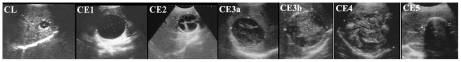
Ultrasound classification of cystic echinococcosis based on WHO expert consensus.CL: as a potentially parasitic cyst, indicates a very early stage of parasite development. CE1 or CE2: suggests active parasite. CE3a: is characterized by detachment cyst membrane and/or partial degeneration of cyst content, without daughter cysts, indicates a transitional stage. CE3b: suggests a transitional stage of parasite, partial degeneration of daughter cysts. CE4 or CE5: indicates an inactive parasite.